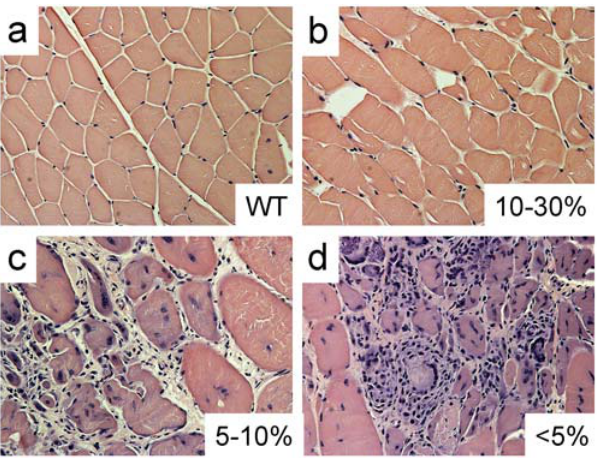
Figure 1. ESC incorporation prevents mononuclear invasion and central nucleation. a–d, Tibialis anterior (TA) muscle from WT